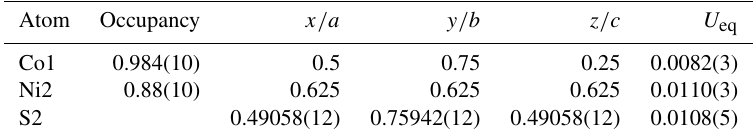
Table 6. Atom positions and equivalent displacement parameters (Å 2 ) for